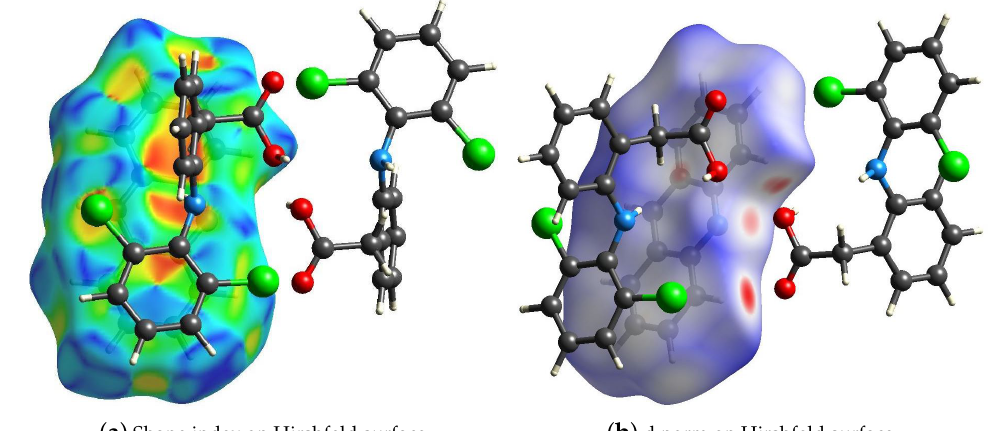
Figure 6. Hirshfeld surface for the LAG 1:1